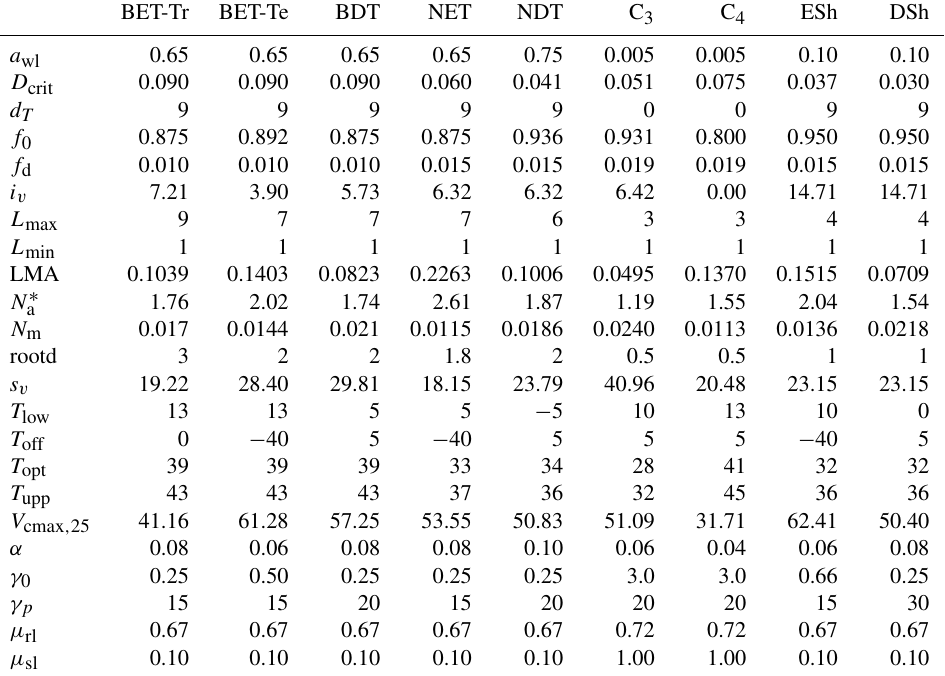
Table 2. Updated parameters used in JULES9 ALL . The new PFTs are tropical broadleaf evergreen trees (BET-Tr), temperate broadleaf evergreen trees (BET-Te), needle-leaf evergreen trees (NET), needle-leaf deciduous trees (NDT), C 3 grass, C 4 grass, evergreen shrubs (ESh), and deciduous shrubs